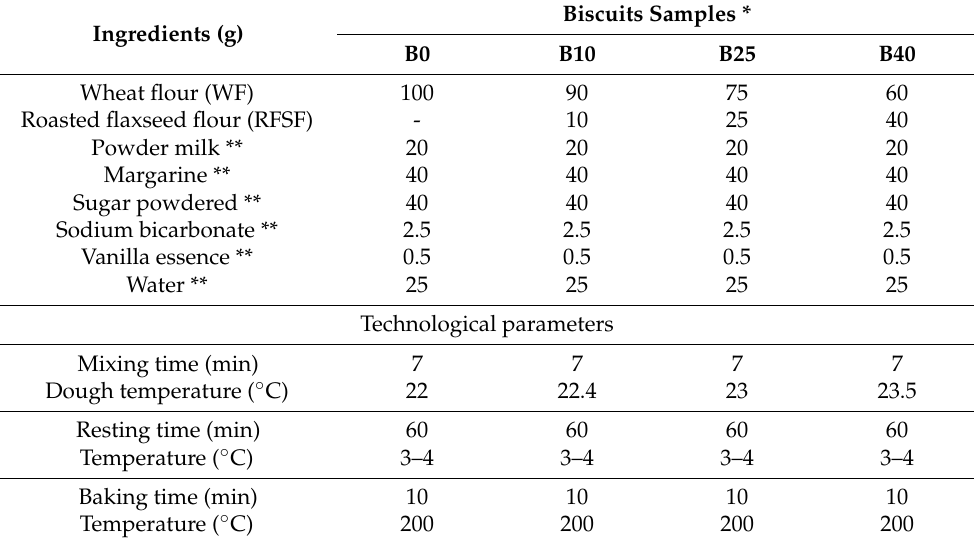
Table 1. Ingredients and technological parameters used in the preparation of biscuits. Ingredients